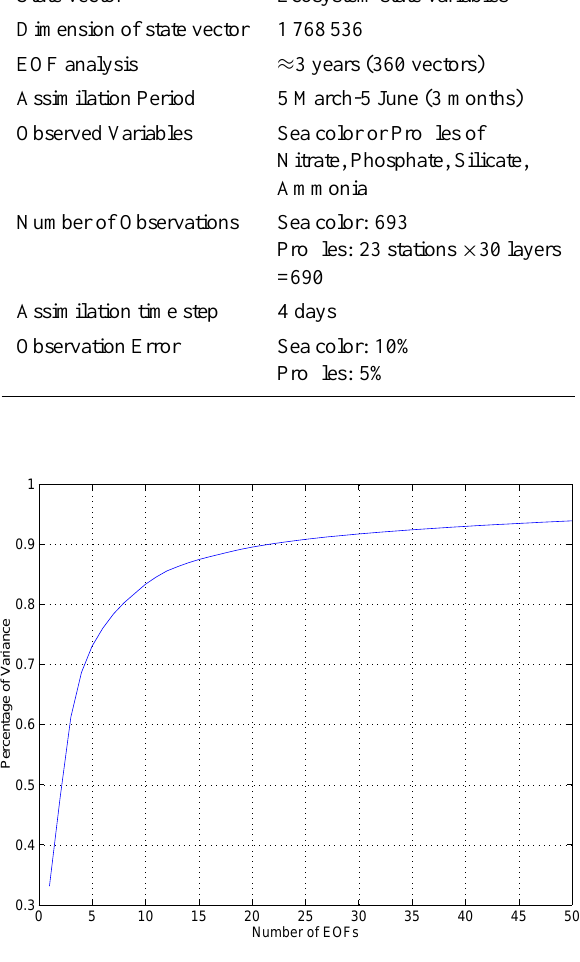
Fig. 3. Percentage of variance explained by the EOFs versus the number of retained